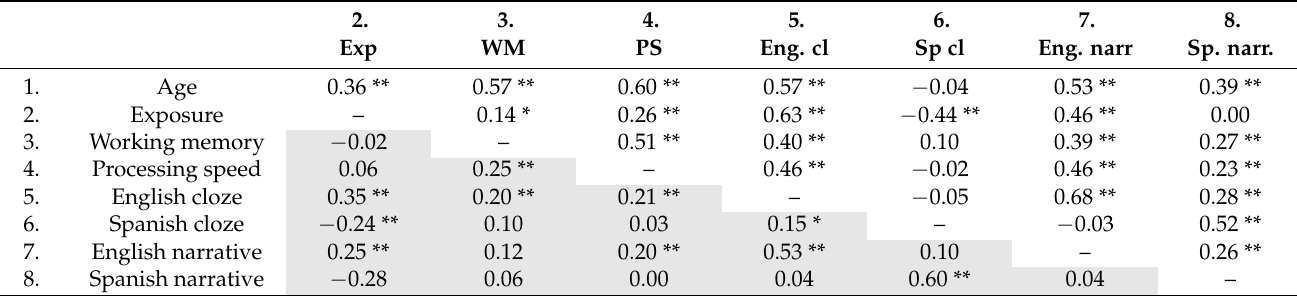
Table 3. Bivariate correlations above the diagonal; partial correlations, controlling for age, below the